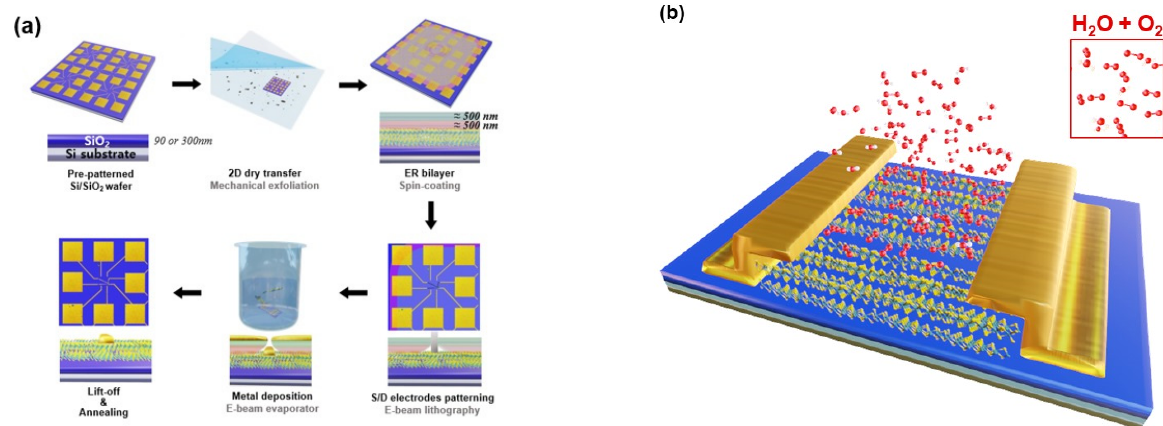
Figure 1. ( a ) Fabrication flow for FET devices and ( b ) schematic illustration of MoTe 2 FET.